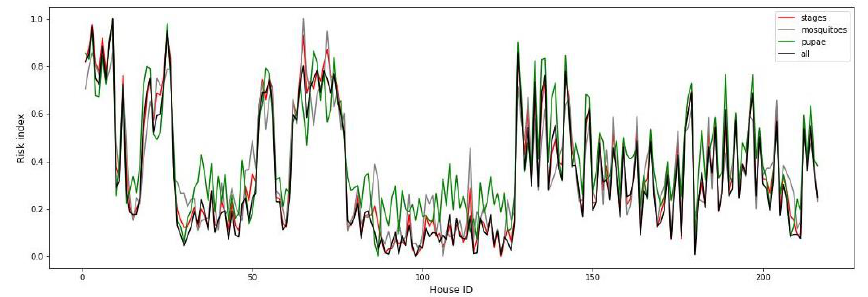
Figure 7. House-level risk index based on PLS for different response variable Y .